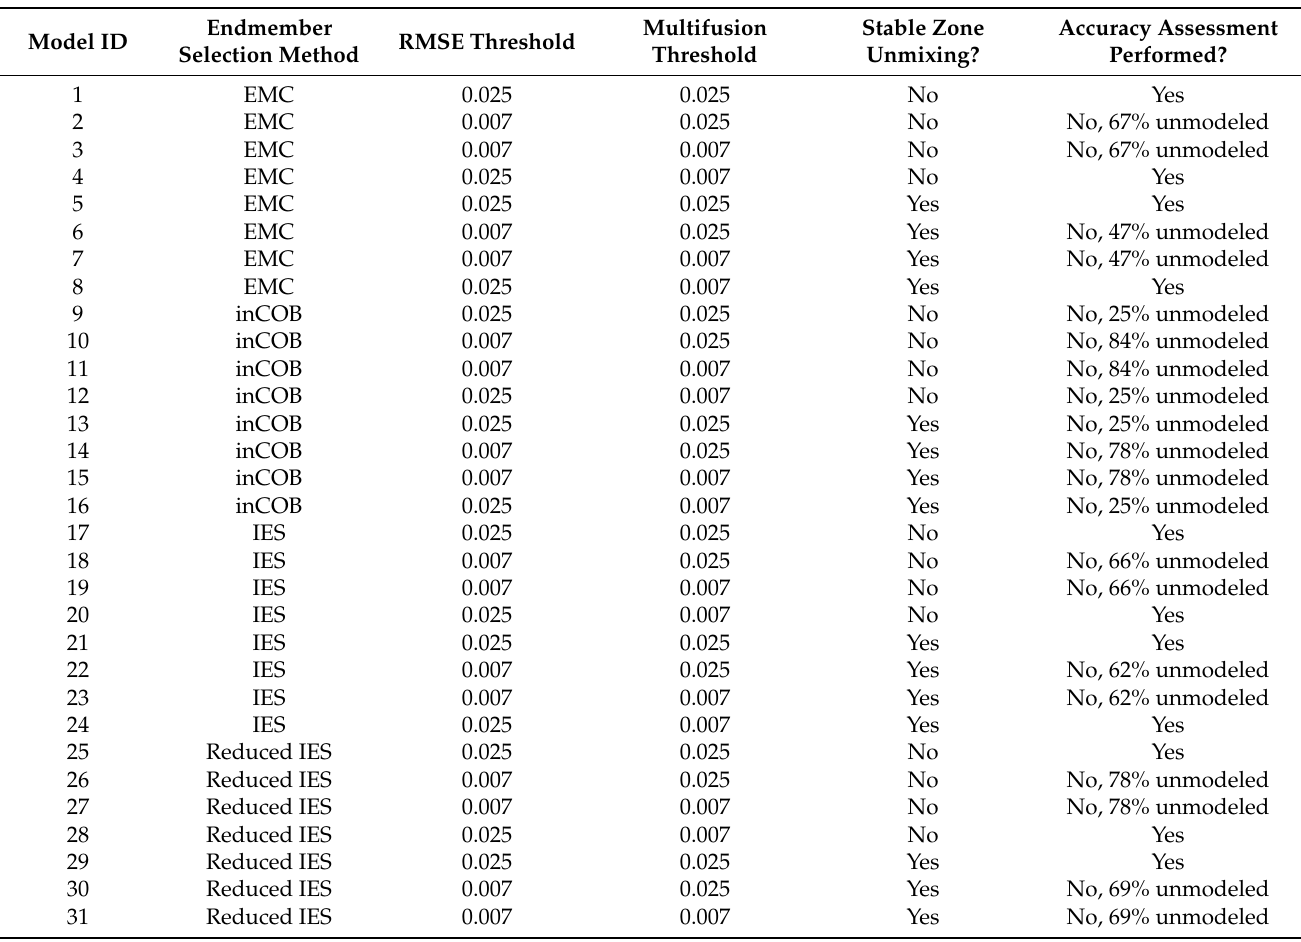
Table A1. Log of MESMA attempts by endmember selection strategy and model constraints. All MESMA was performed on Landsat imagery collected 06/30/2019, with a 30% maximum shade constraint, and incorporated three- and four- endmember